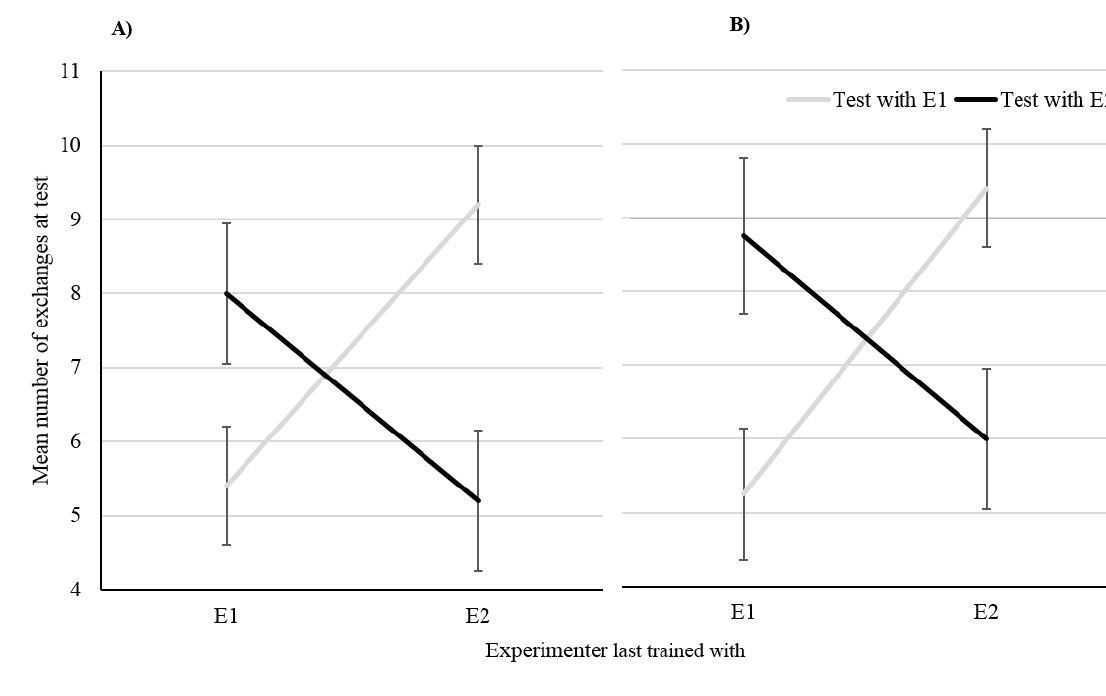
Figure 5. Mean number of exchanges in the test with E1 and E2 by experimenter with whom they last trained. A) Depicts subjects in the 2-week delay period, B) depicts subjects in the 10-week delay period. Error bars denote standard